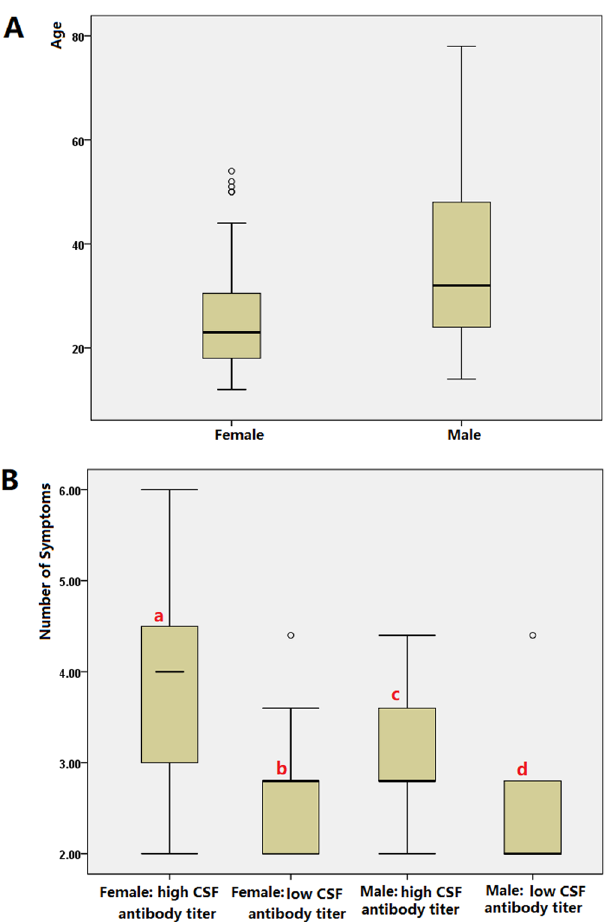
Figure 1. ( A ) The male patients were older than the female patients (36.49 ± 2.3 vs 25.94 ± 1.64, P = 0.000). ( B ) Patients with high CSF antibody titers experienced more clinical symptoms than those with low CSF antibody titers (a vs b: mean 4.06 ± 0.98 vs 1.88 ± 0.86, P = 0.000; c vs d: mean 2.29 ± 1.0 vs 1.50 ± 0.79, P = 0.006). Similarly, more clinical symptoms were observed in the female patients than in the male patients (a vs c: mean 4.06 ± 0.98 vs 2.29 ± 1.0, P =